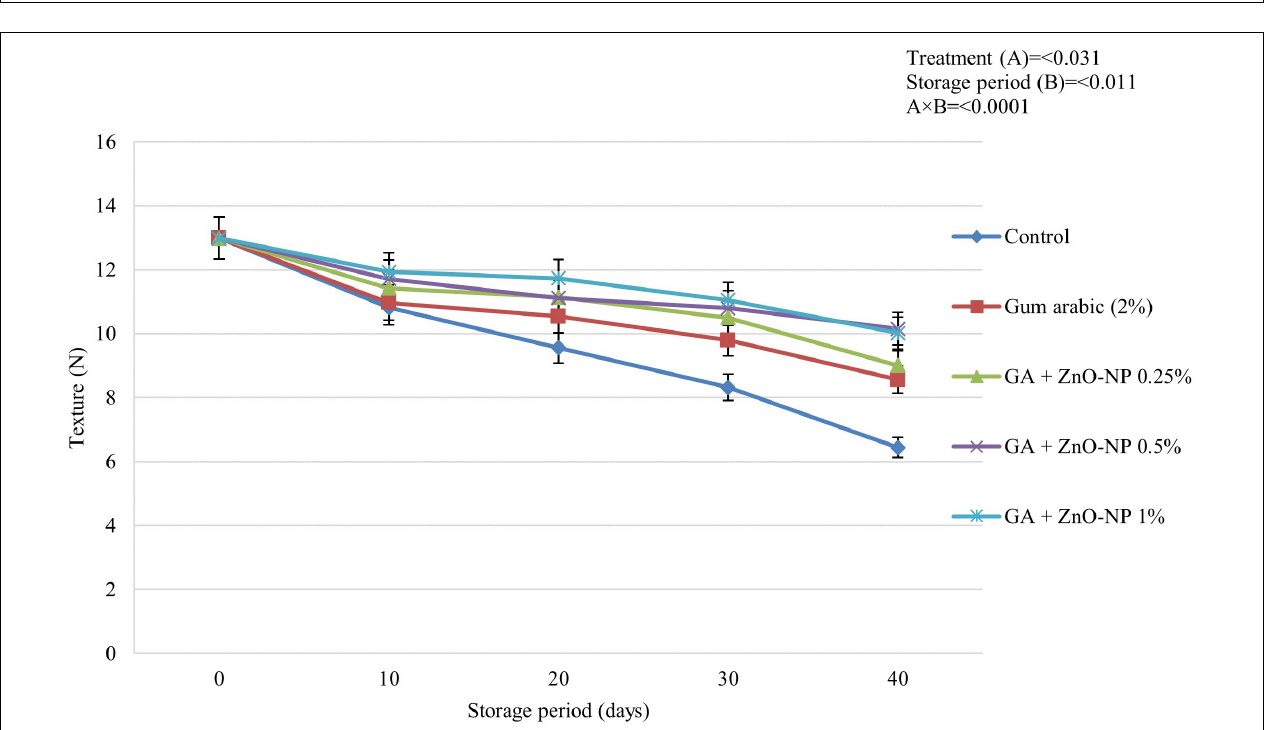
FIGURE 4 | Citrus color index of ‘Kinnow’ mandarin fruit during storage for 40 days at 5 ± 1 ◦ C. Error bars denote the standard error (SE) of the mean. Means ± standard errors presented. To determine the interaction effects, factorial ANOVA was performed for the main factors, treatment, and storage time. GA + ZnO-NP, gum arabic + zinc oxide nanoparticles.